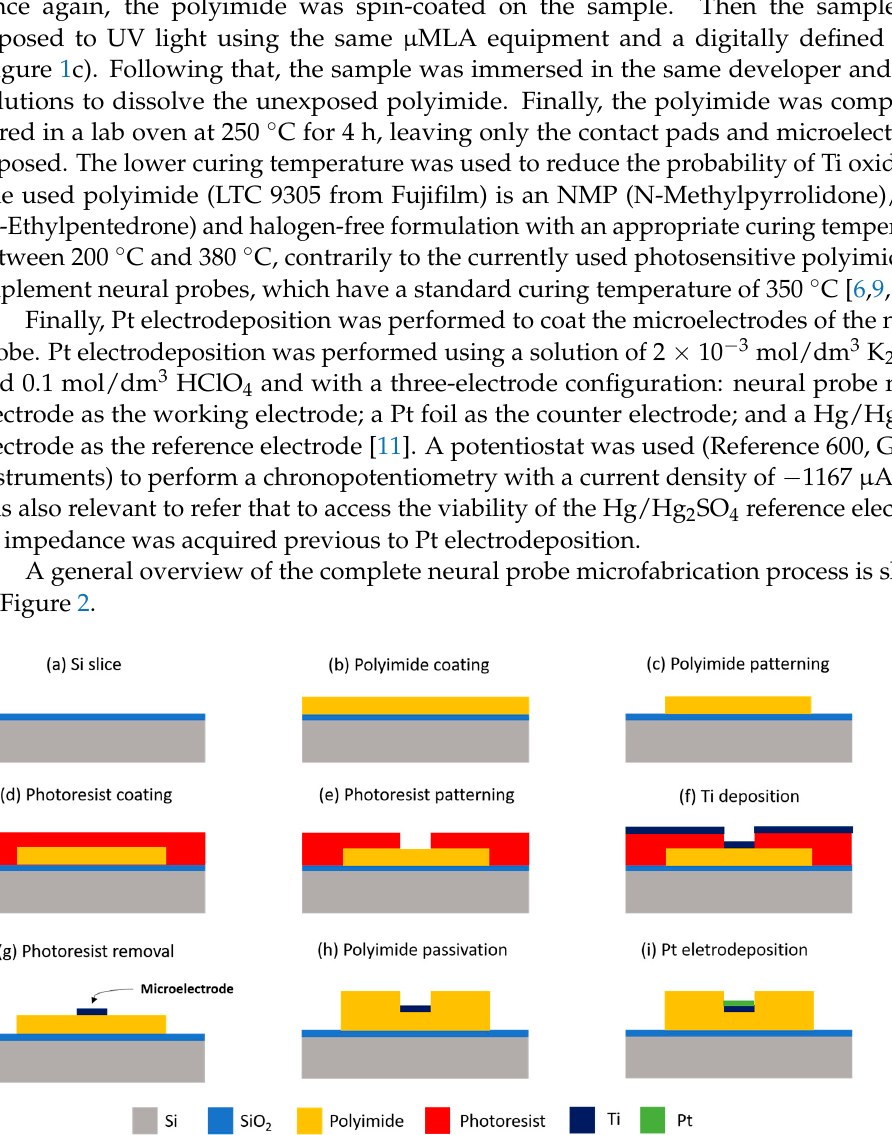
Figure 2. Overview of the neural probe fabrication process. The neural probe release from the sacrificial Si slice is achieved by wet etching of the sacrificial SiO 2 thin-film, which is deposited between the Si and the